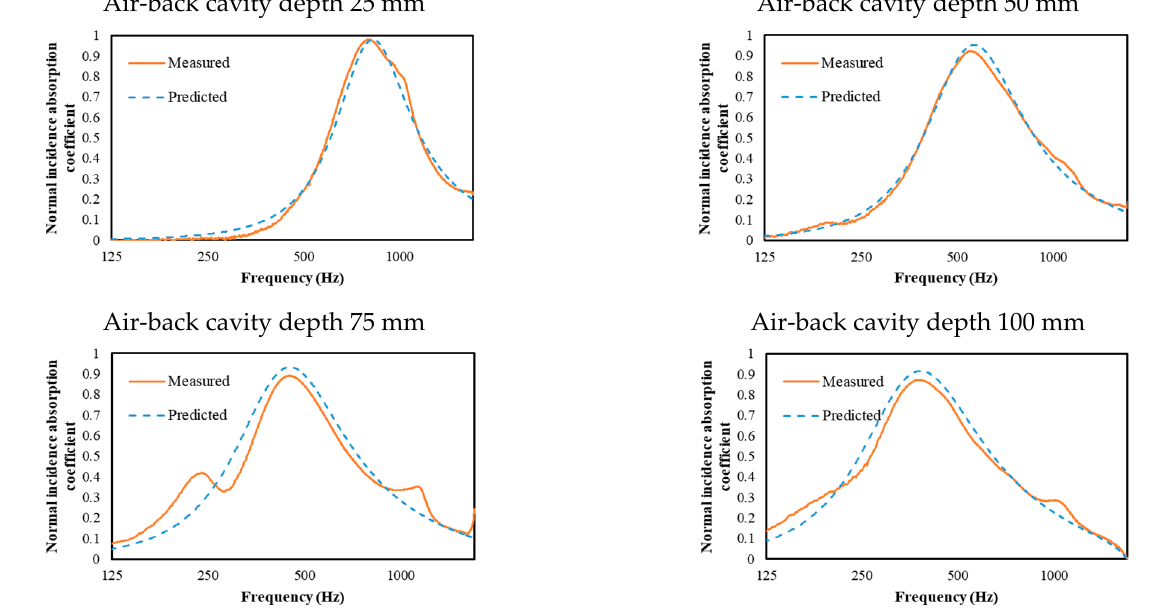
Figure 5. Comparison of the measured and predicted values of the normal incidence sound absorption coefficient of specimen 1. The orange solid line represents the measured values, and the blue dotted line represents the predicted values. Table 2. Mean values of the error indices for the four conditions of air-back cavity depth of specimens 1 and 2.